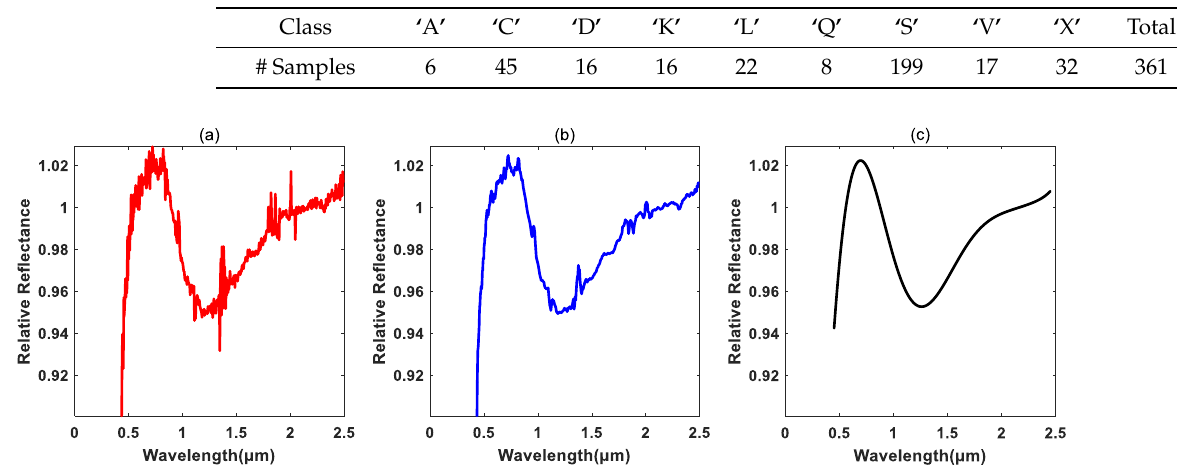
Figure 3. The spectral preprocessing for (1) Ceres with category ‘C’. ( a ) Original spectra; ( b ) smoothed spectra; ( c ) fitted spectra spanning the wavelength range from 0.45 to 2.45 μ m.